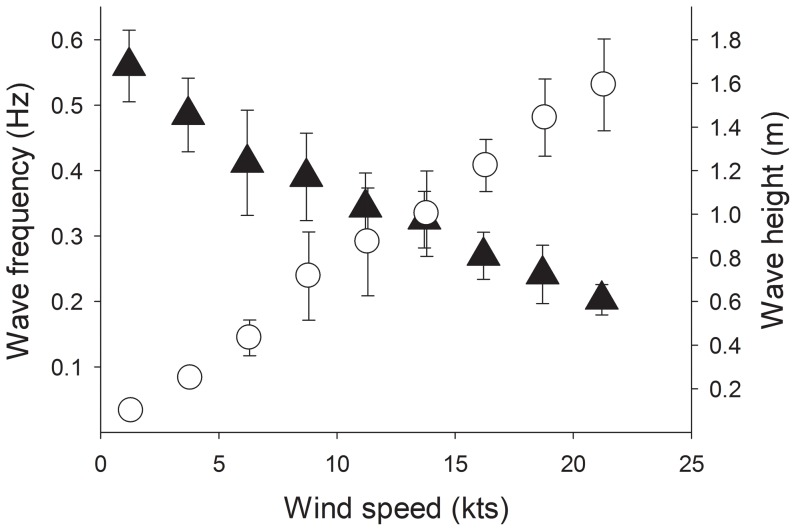
Wind induced wave frequency and amplitude in an exposed coral reef habitat (mean ±S.E.).Wave frequency (black markers) was measured on the exposed slope in front of Lizard Island, and wave amplitude (white markers) was estimated from marine forecasts for this location (www.bom.gov.au).